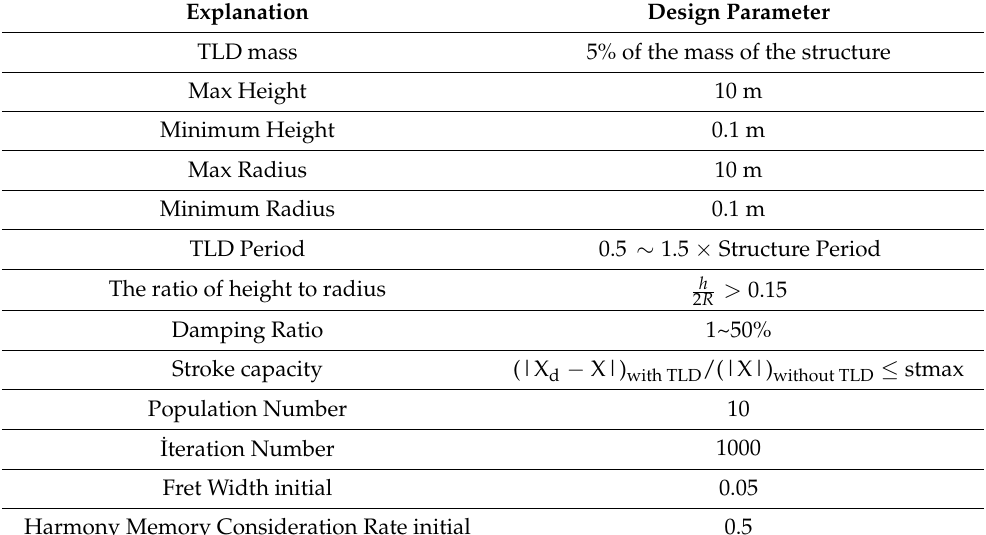
Table 3. TLD and optimization design parameters.